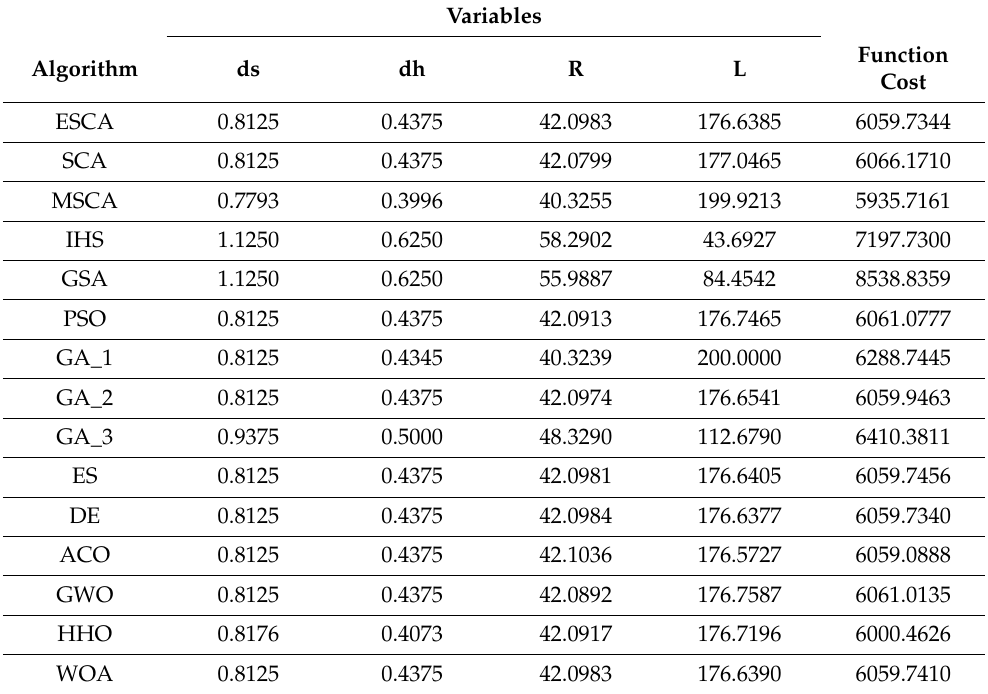
Table 24. Design variables and comparison of the best solutions obtained for pressure vessel